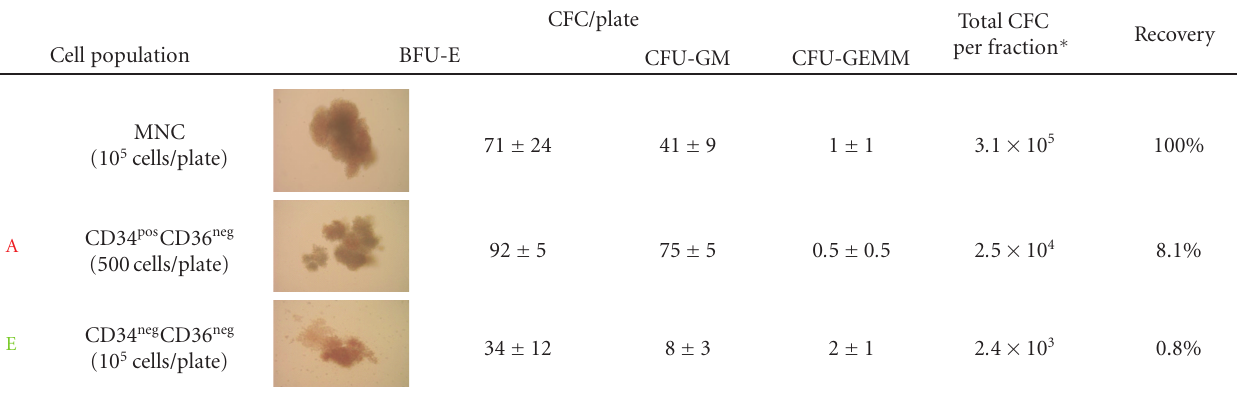
Table 2: Cloning e ffi ciency of AB MNC and AB cell populations prospectively isolated on the basis of CD34/CD36 expression. Results are presented as mean ( ± SD) of those observed in three independent experiments. The inserts present the morphology of a